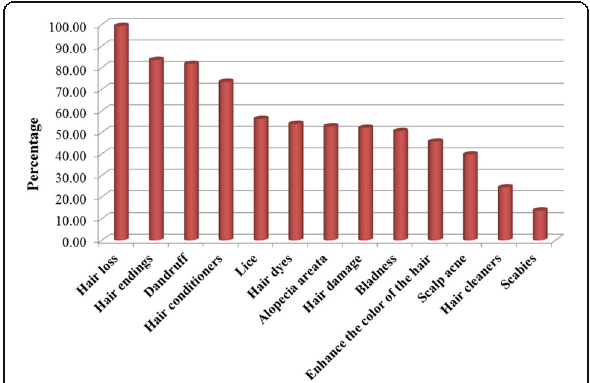
Fig. 5 Hair and scalp disorders treated by minerals and/or animals